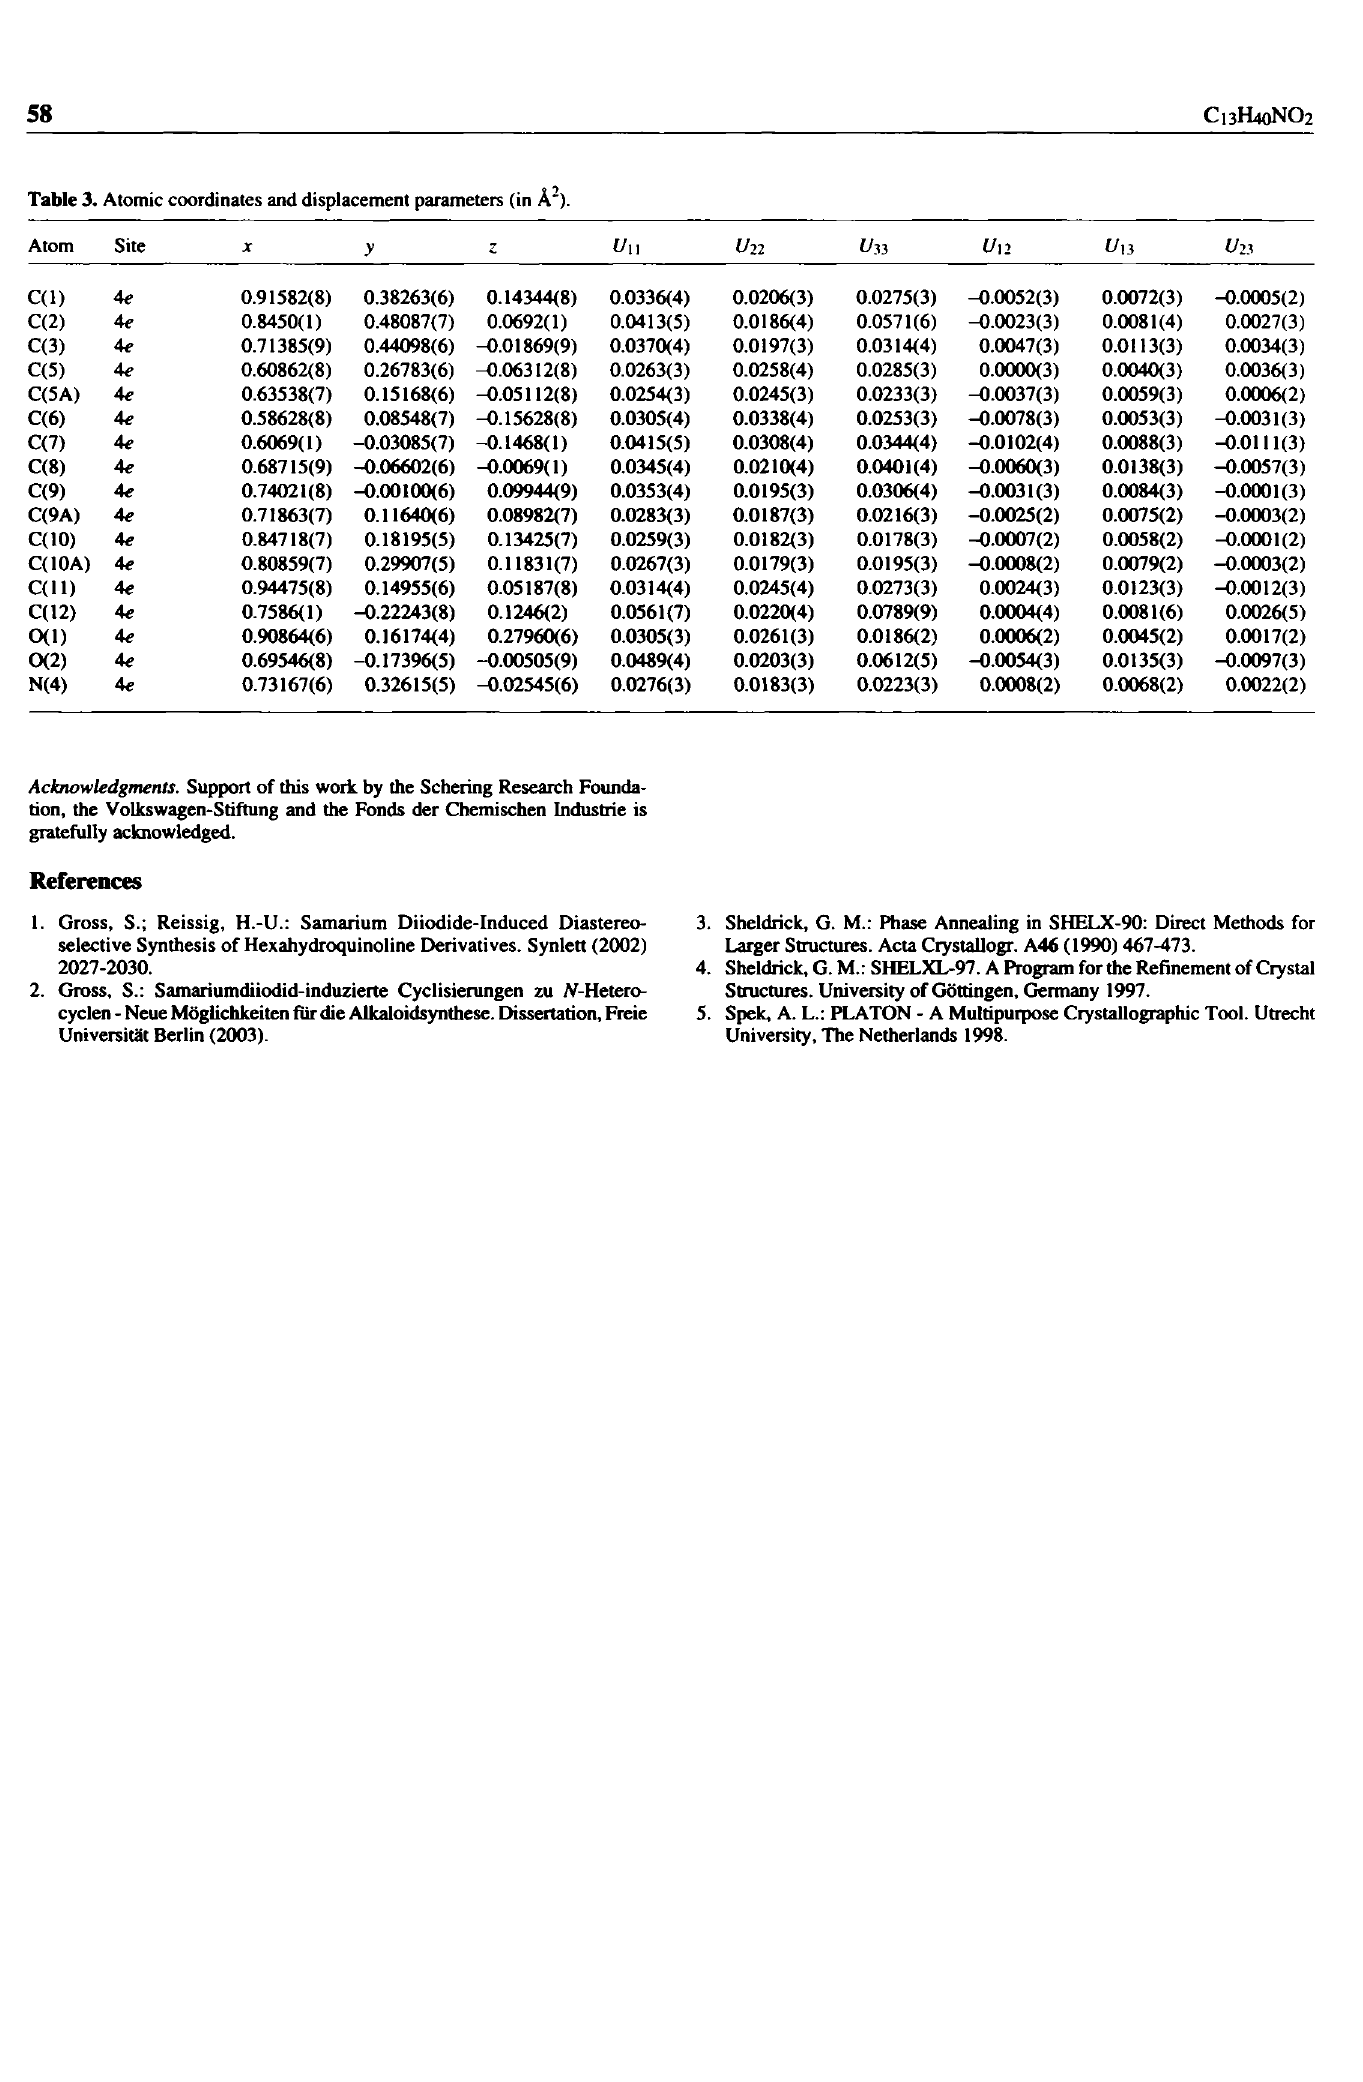
Table 3. Atomic coordinates and displacement parameters (in A 2